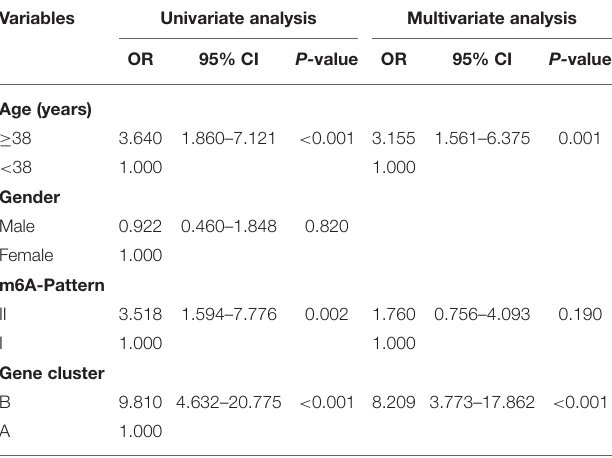
TABLE 4 | Ordinal logistic regression